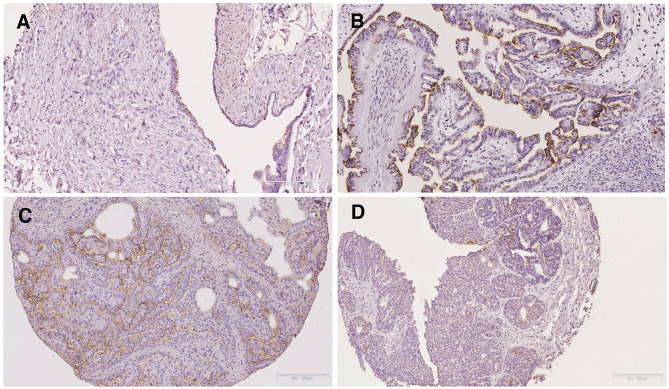
Immunohistochemical staining of S-Lc4 in ovarian tumors with different grade of malignancy. Representative images of immunohistochemical staining of carcinomas with different levels of malignancy. Tumor types include (A) Serous cystadenoma, (B) Borderline type serous tumor, (C) Low grade serous carcinoma, and (D) High grade serous carcinoma. Scale bar represent 200 μm.